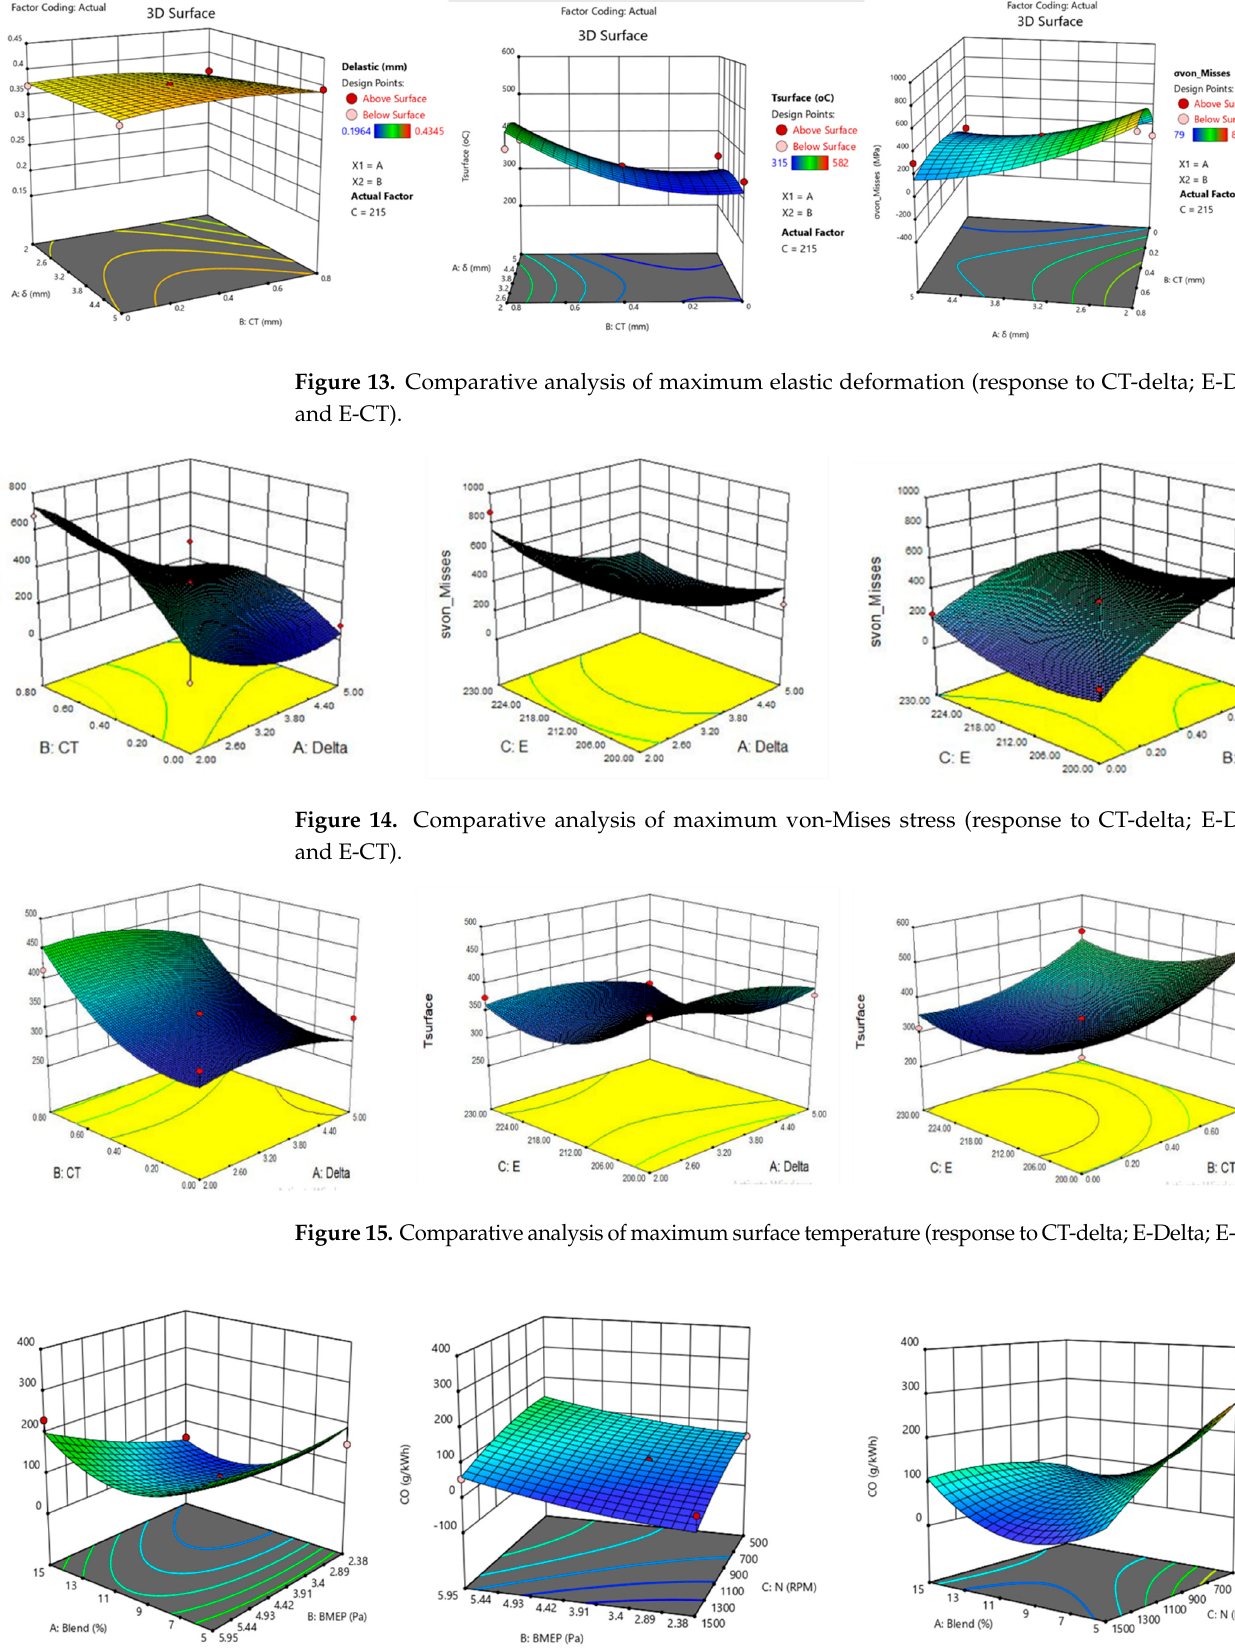
Figure 16. Comparative analysis of maximum CO emission (response to blend-BMEP; BMEP-N;